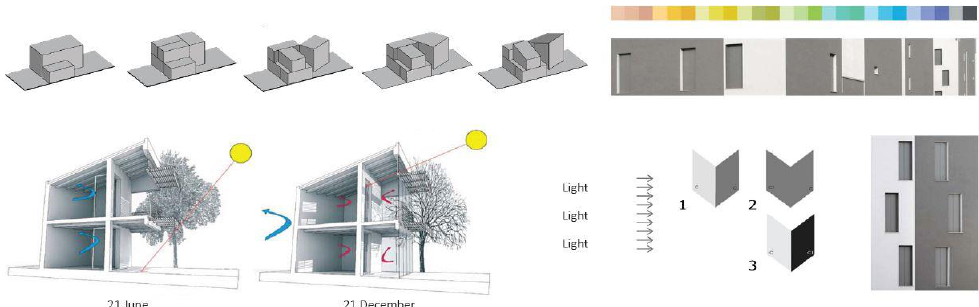
Figure 13. Volumes’ composition ( top left ); section of terrace house with passive strategies ( bottom left ); color plan by Jorrit Tornquist ( right ) (source: © Boschi + Serboli Architetti Associati).